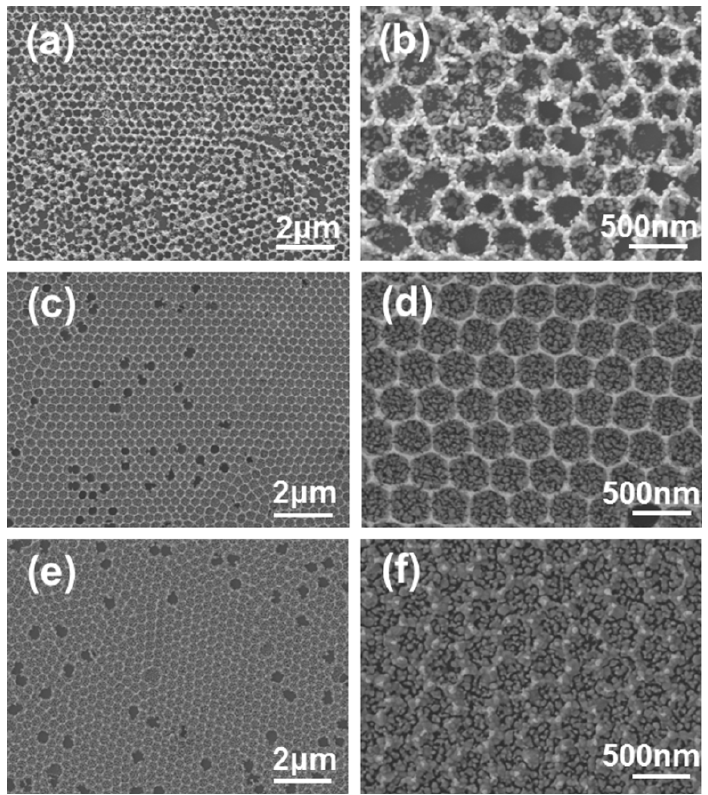
Figure 3. SEM images of ZnO IO films on SiO 2 /Si substrates fabricated at different CA/ZA molar ratios: ( a , b ) 0:1; ( c , d ) 0.2:1; ( e , f ) 1:1.